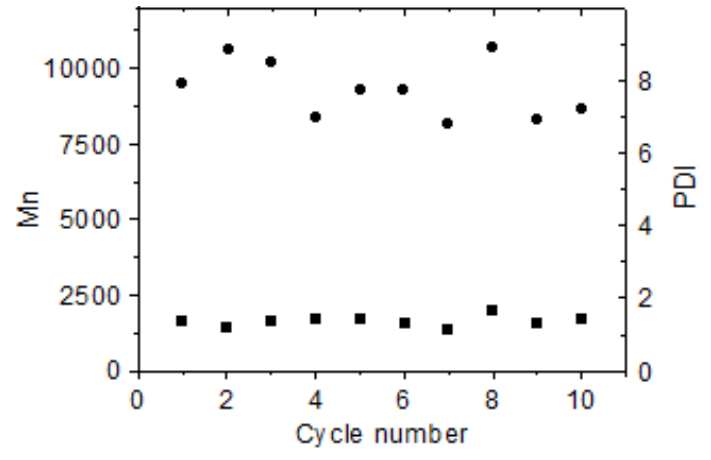
Figure 5. The recovery results of the catalyst. ● , Mn; ■ ,